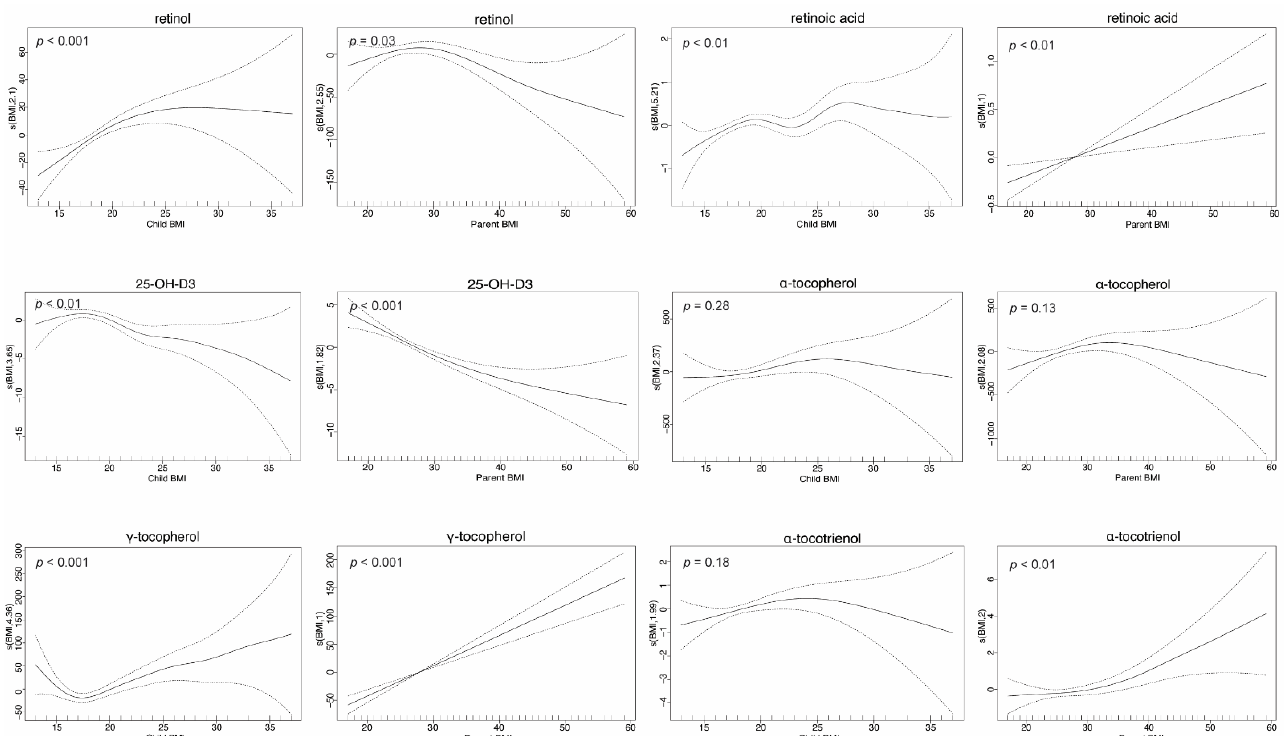
Figure 4. Generalized additive models of the BMI effect on FSV concentrations. The number in s (BMI, number) is the degrees of freedom selected by the generalised cross-validation. When the number is one the procedure has selected a linear fit for the model. The dotted lines are estimate +/− two standard errors. The smooth functions are constrained to sum to zero over the observed covariate values; when a linear model is selected, this means the function must be zero at the mean of the observed covariate values (0 uncertainty). The extreme ends of the curves are influenced by a small number of data points with unusual covariate values; this is reflected in the large window of uncertainty for these regions.